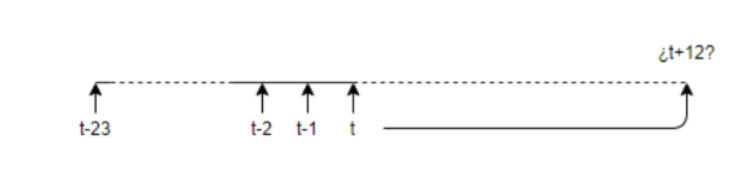
Figure 8. Windows